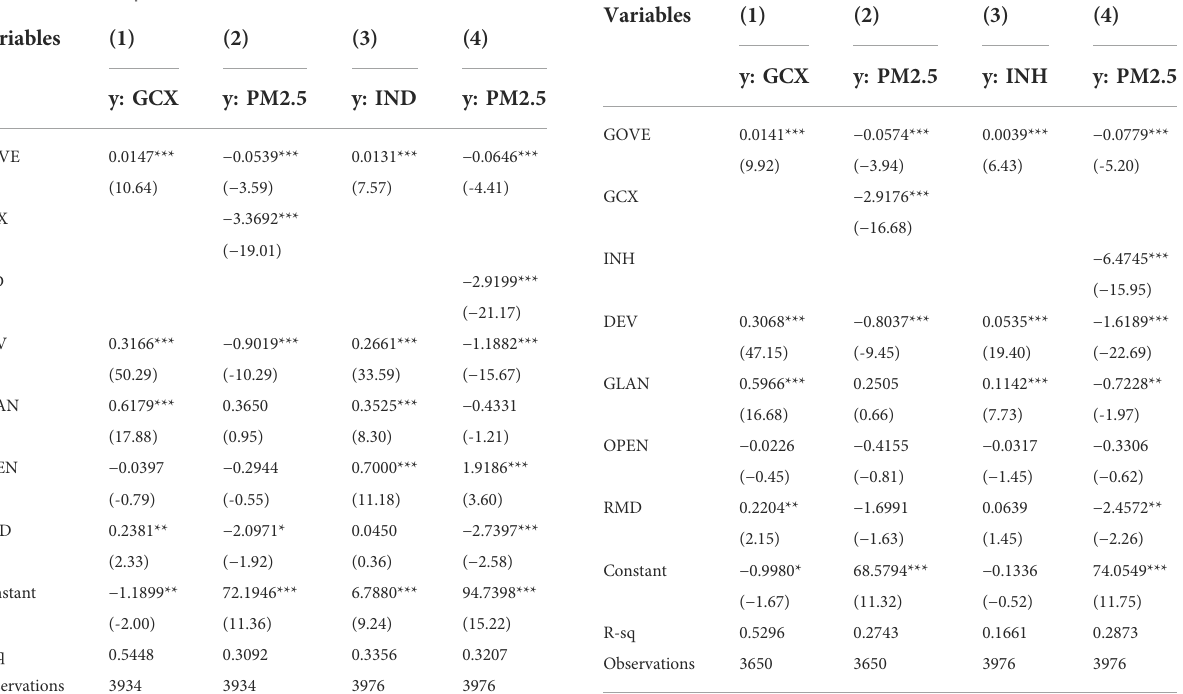
TABLE 4 Robustness tests of the intermediary